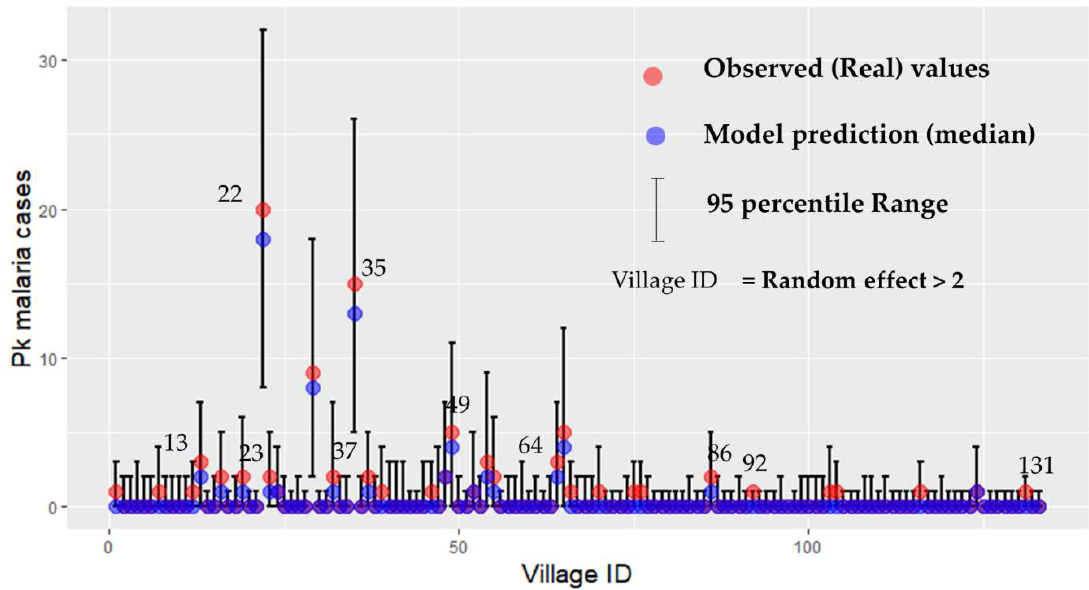
Figure 3. This figure compares the observed (real) cases of Pk malaria and the predicted (median), 95 th percentile range of Pk malaria cases based on GLMM Model 3. The y axis is the Pk malaria cases and the x axis is each village ID from 1 to 133.